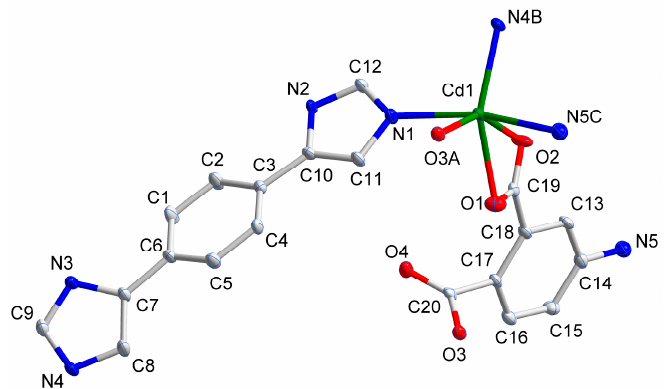
Figure 1. The coordination environment of Cd(II) ion in 1 . Symmetry code: A 0.5 − x, 0.5 − y, − z, B x, 1 + y, z, C x, 1 − y, − 0.5 + z.